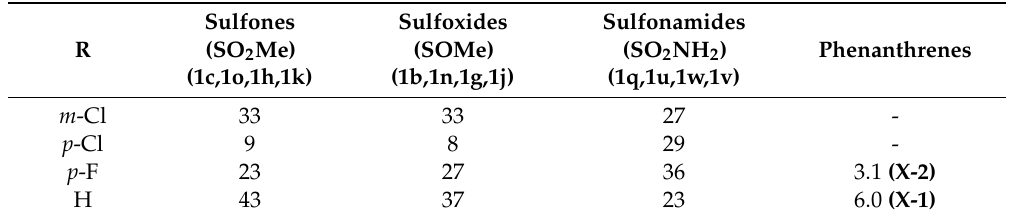
Scheme 3. Synthesis of phenanthro[9,10-b]furanones ( 2 ) by photochemical cyclization of the stilbene moiety of 4,5-diaryl-3( 2H )furanones 1 . Table 4. Total yield (%) of desired 4,5-diarylfuran-3( 2H )-ones 1 – 2 starting from benzophenones.